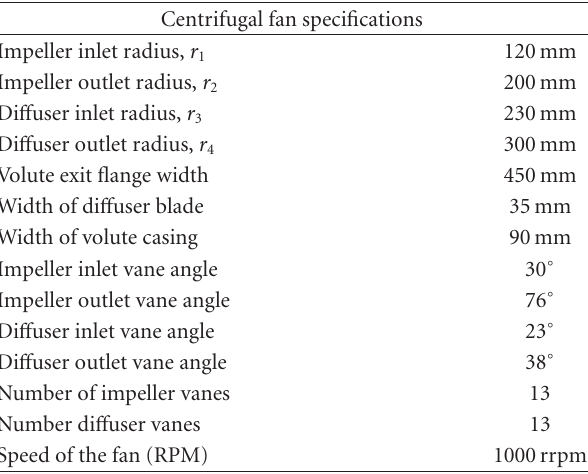
Table 1: Specifications of the centrifugal